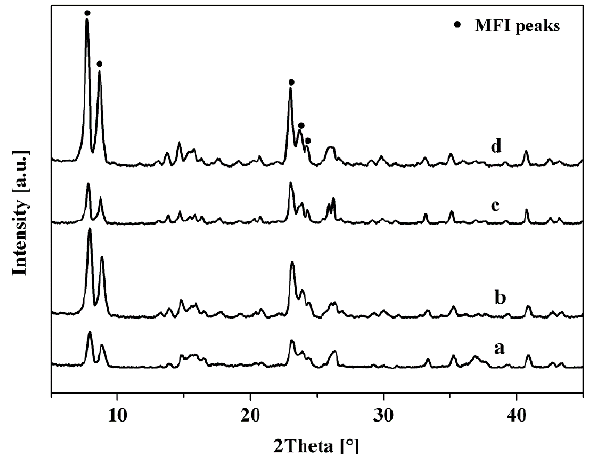
Figure 5. XRD patterns of TS-1 zeolite membranes with different morphology of seeded crystals. ( a ) M-3; ( b ) M-4; ( c ) M-5; ( d ) M-6.